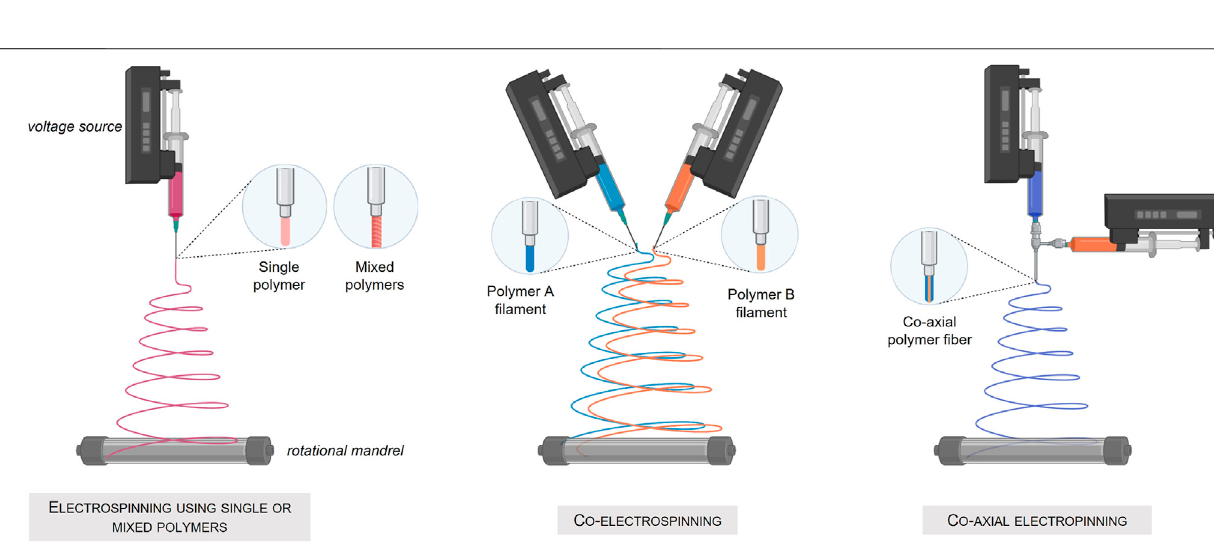
Frontiers in Bioengineering and Biotechnology |